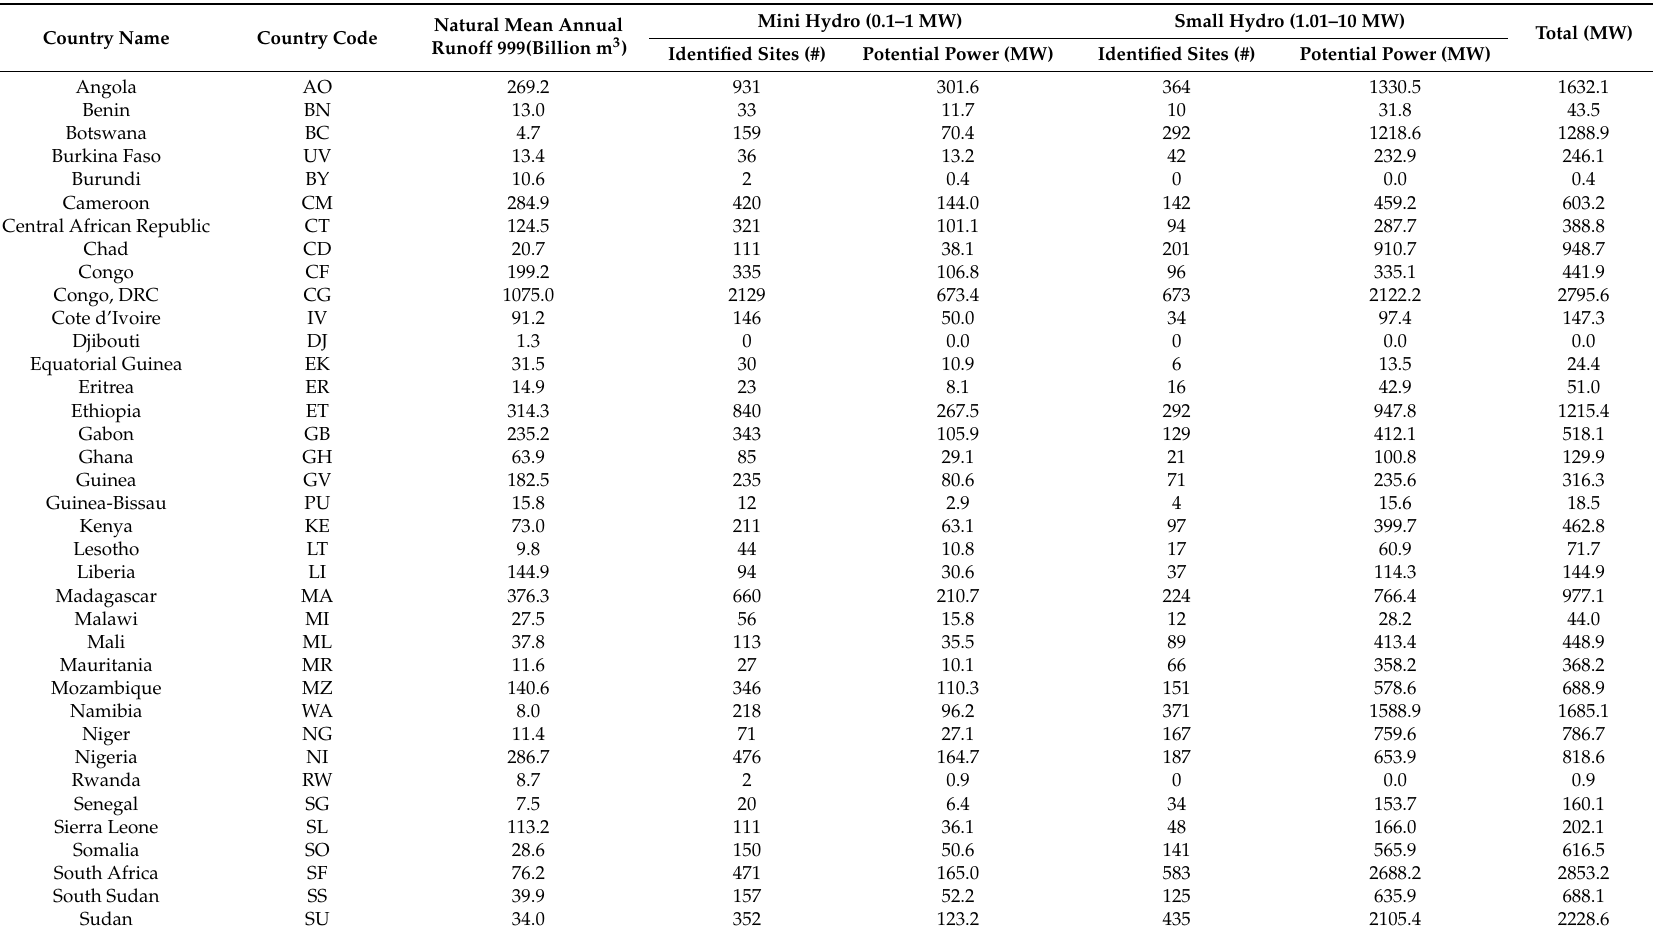
Table A2. Mini and small hydropower technical potential per country for 44 Dub-Sahara African